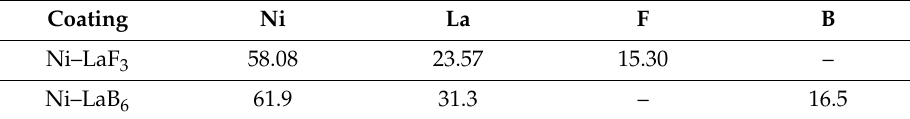
Table 4. X–ray spectral analysis of the composite coatings, wt%.